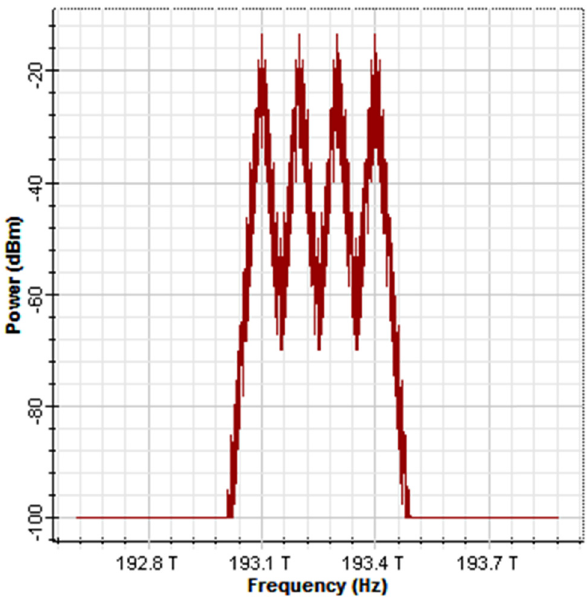
Figure 4: The power vs frequency of the drop signals for all channels directly after the ideal multiplexer before the transmis - sion link. ( 2 ) In Figure 5, from the oscilloscope visualizer, the comparison of amplitude vs time is shown as add channel_1 ( 193.1 THz ) to channel_4 ( 193.4 THz ) after 200 km of fi ber optic transmission link directly of Solitons type after photodiode and fi lter at the receiver side, which are good in the fi gure.